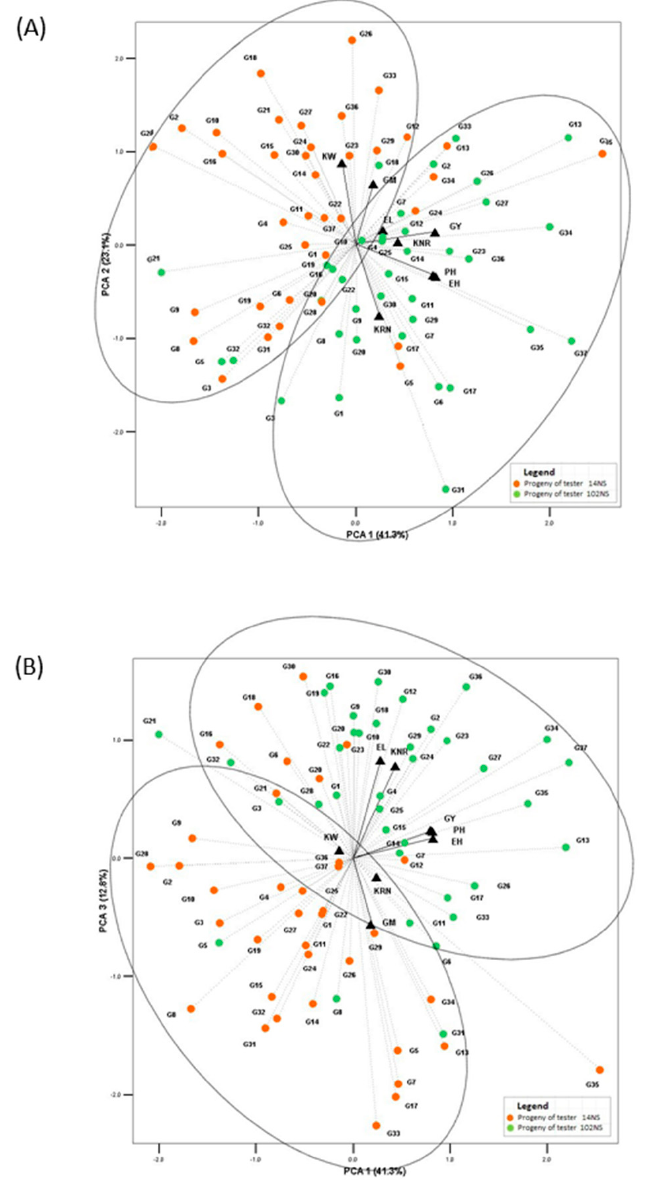
Figure 2. ( A ) PC1 vs. PC2 biplot of maize landrace top-crosses for eight quantitative traits; ( B ) PC1 vs. PC3 biplot of maize landrace top-crosses for eight quantitative traits.